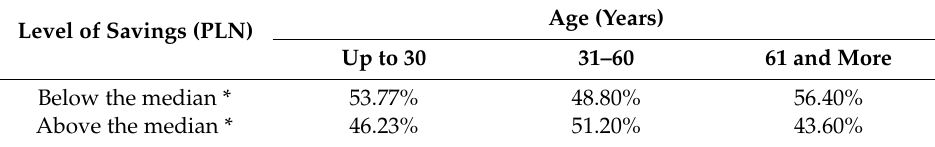
Table 2. Age of the farmer and the level of savings generated by small farms in Poland. Age (Years) Level of Savings (PLN) Up to 30 31–60 61 and More Below the median * 53.77% 48.80% 56.40% Above the median * 46.23% 51.20% 43.60%